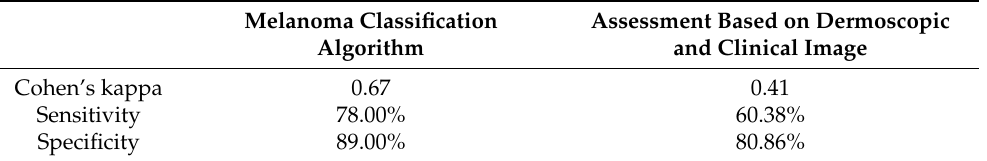
Table 1. Comparison of the melanoma classification algorithm and the assessment based on dermo- scopic and clinical images by dermatologist and dermatology residents ( n =